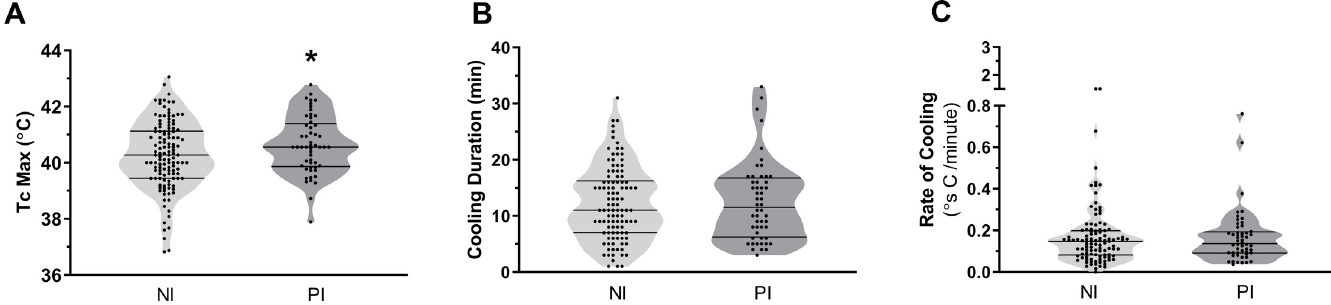
Fig 1. Violin plots representing response to cooling. ( A) Tc max (rectal maximal core temperature in degrees Celsius), (B) cooling duration (minutes cooled), and C. Rate of cooling (degrees Celsius per minute). Tc max is significantly higher in PI whereas rate of cooling and duration are similar between groups. Welch’s Test for unequal variance, � P � 0 . 05 .